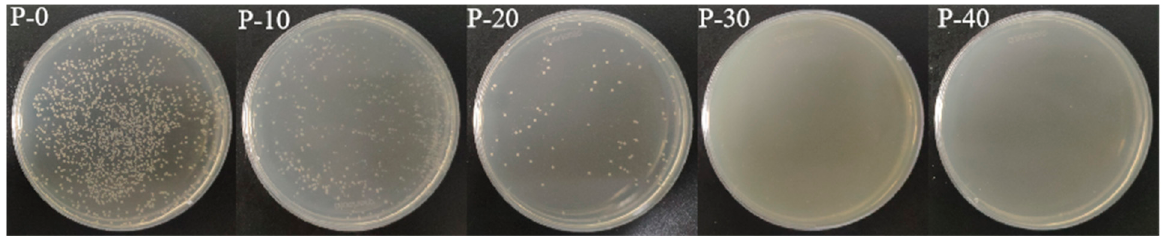
Figure 6. Antimicrobial activity of P − 0, P − 10, P − 20, P − 30, and P − 40 monofilaments against Escherichia coli .